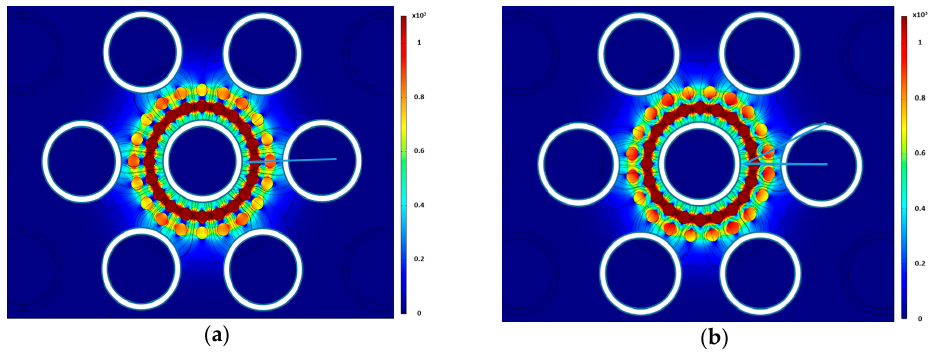
Figure 13. Electric field contour for relative angles between the two sets at ( a ) 0° and ( b ) 10°.